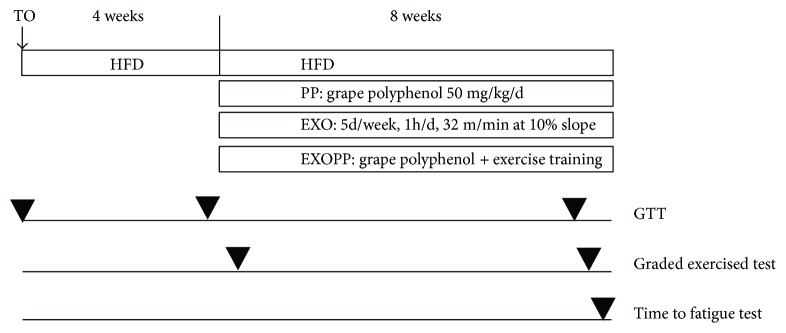
Experimental design. After 4 weeks of HFD, 40 male Sprague-Dawley rats were divided into 4 groups (n = 10/group) while simultaneously continuing for an 8-week period the HFD alone (HF), HFD, and supplementation with grape polyphenol extract (PP) at 50 mg/kg/d per 50 ml of drinking water (PP), HFD, and exercise training 1 hr per day/5 days/wk consisting of running on a treadmill set at 32 m/min for a 10% slope (EXO), HFD, and PP supplementation combined with exercise training (EXOPP). Glucose tolerance tests (GTT) were performed at T0, 4, and 11 weeks. A graded exercise test was completed between the 4th and the 5th week and between the 11th and the 12th week where a time-to-fatigue test was also done.